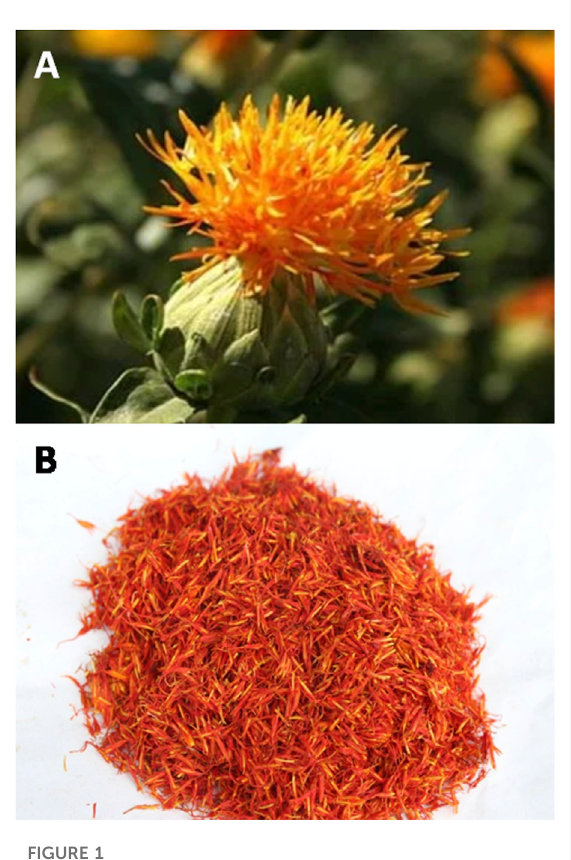
FIGURE 1 (A) Cathamus tinctorius L ., (B) CarthamiFlos (the dried fl orets of C. tinctorius